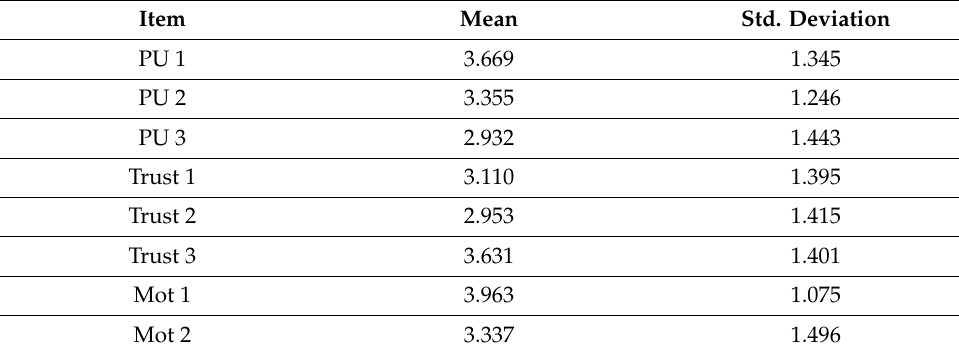
Table 2. The descriptive statistics of the Farmers’ Willingness constructs’ items.